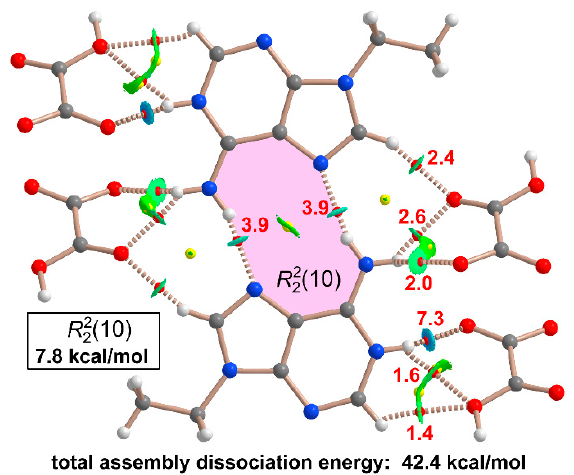
Figure 7. QTAIM distribution of bond and ring critical points (CPs, red and yellow spheres, respectively) corresponding to the H-bonds in the R 22 (10) synthons and its interaction with four surrounding [C 2 O 4 H] – anions. The dissociation energies of the H-bonds are indicated next to the bond CPs. Superimposed NCIplot isosurfaces [ s = 0.5, cut-off = 0.04 a.u., color scale –0.04 a.u. (blue) ≤ (sign λ 2 ) ρ ≤ 0.04 a.u. (red)] are also represented.